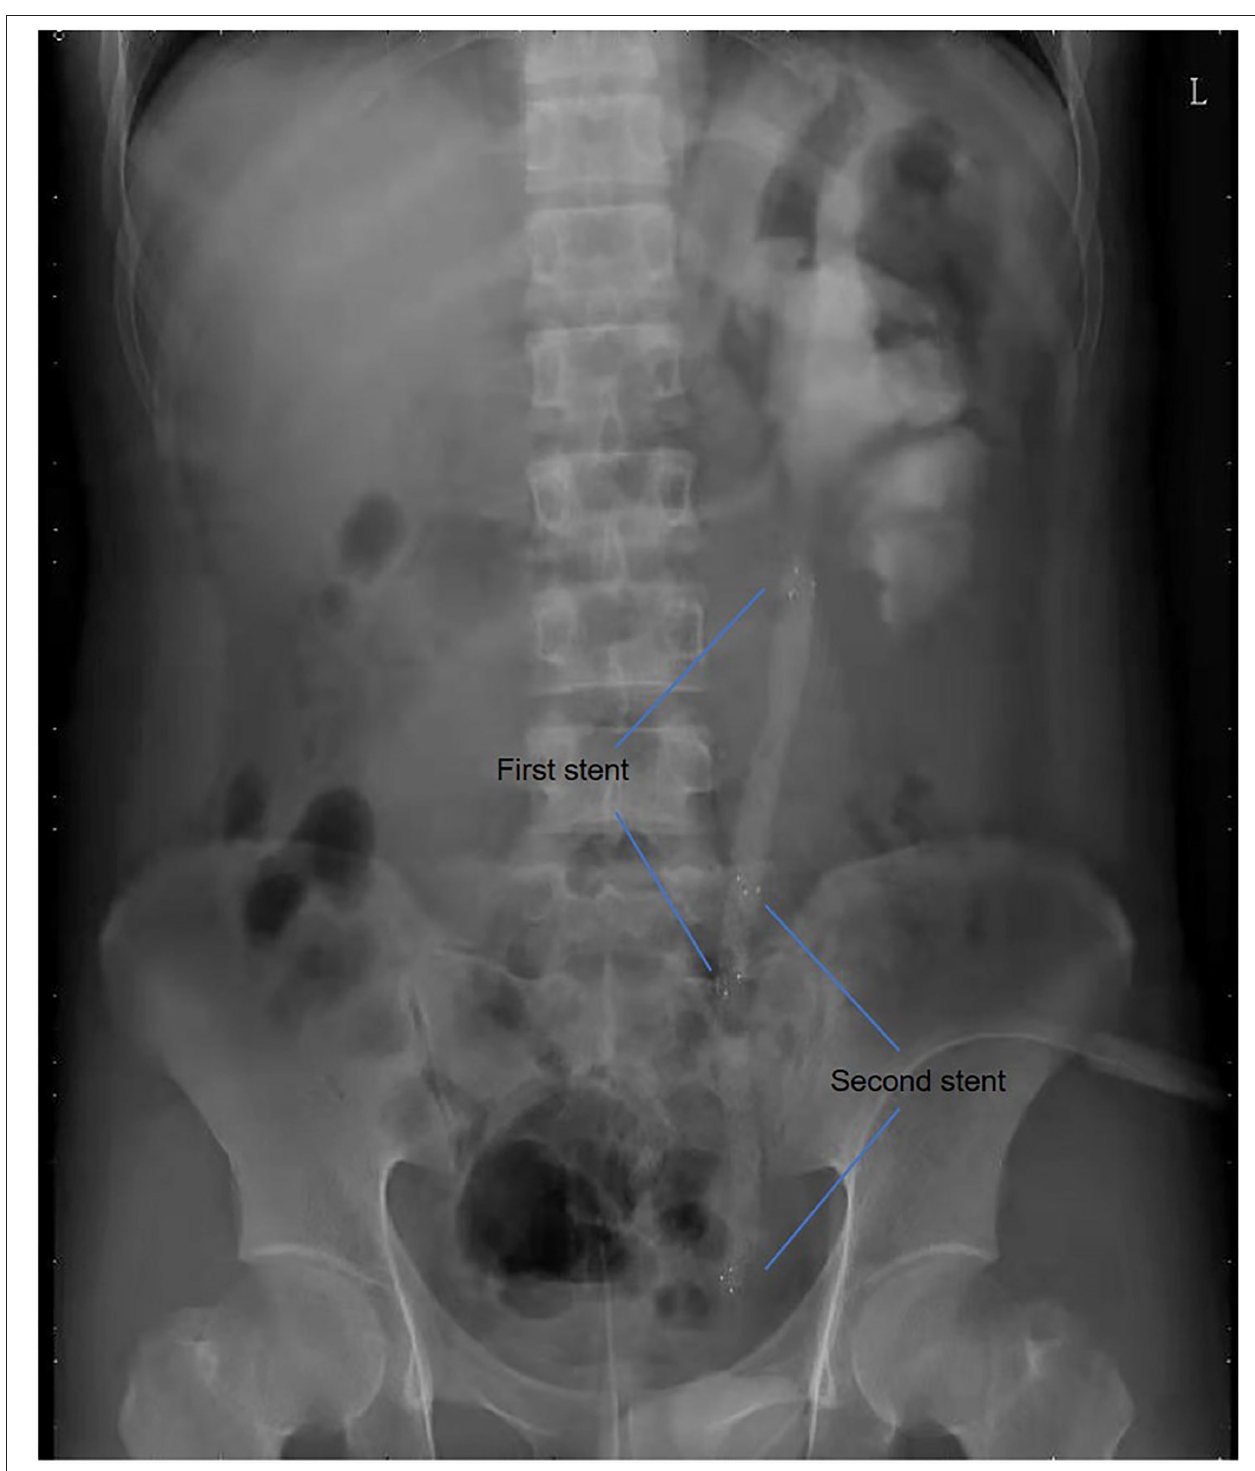
FIGURE 3 | Two stents in tandem for proximal ureteric strictures and long strictures.